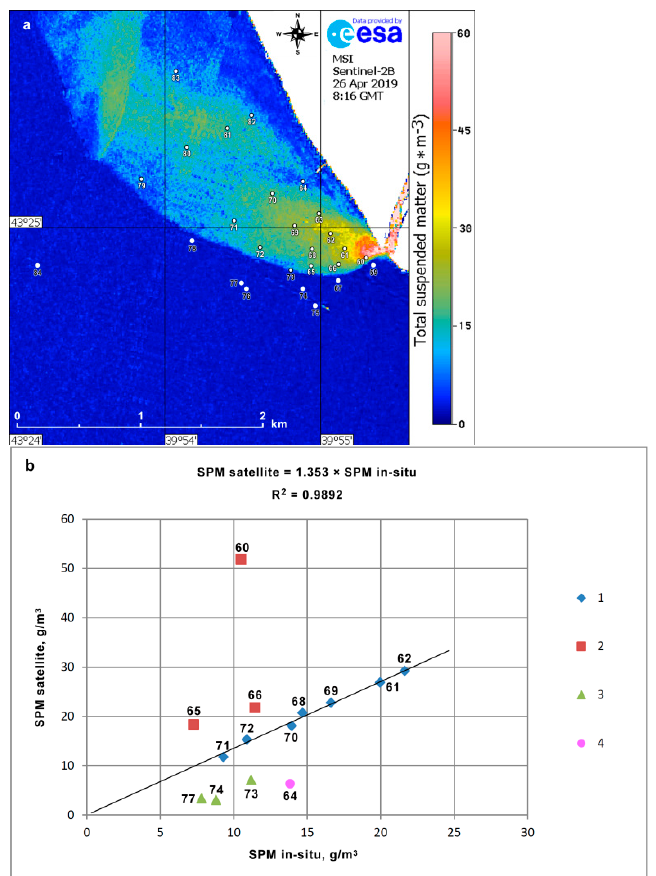
Figure 10. Case 2 Regional Coast Color (C2RCC) performance on Sentinel-2B MSI data of 26 April 2019: ( a ) SPM map with positions of the measurement stations; ( b ) quantitative comparison of SPM satellite and water sampling SPM in situ. In Panel ( b ), Group 1 stations (blue) retained their positions relative to the plume boundary during the time between satellite overflight and water sampling; Group 2 (red) stations were located directly at the plume boundary at the time of water sampling. In the satellite image, they are inside the plume; Group 3 (green) stations were inside the plume at the time of water sampling. In the satellite image, they are outside the plume; Group 4 station (magenta) is located opposite the pier. The station numbers are indicated beside the marks. The trend line is drawn only for Group